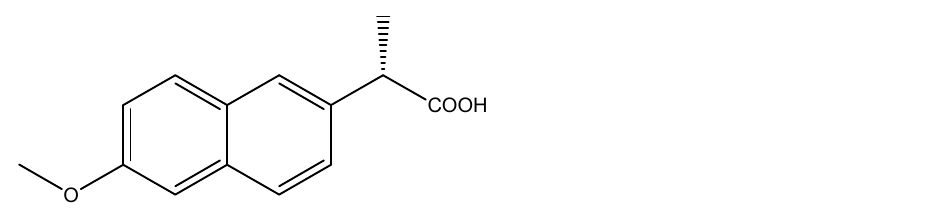
Figure 1. The chemical structure of Naproxen (( S )-(+)-6-Methoxy-α-methyl-2-naphthaleneacetic